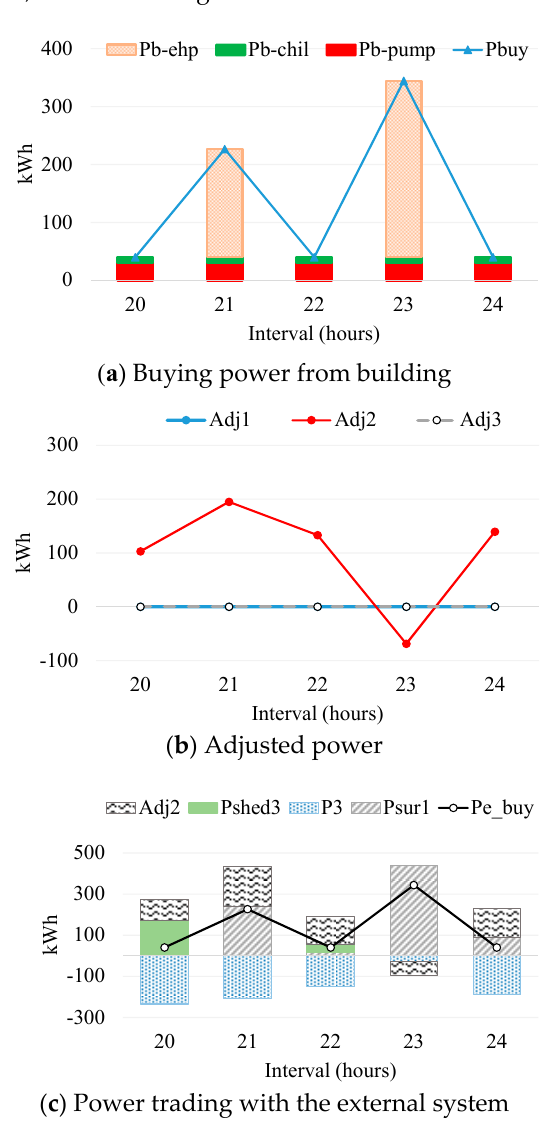
Figure 12. Rescheduling for the event case at interval 20 during a weekday.